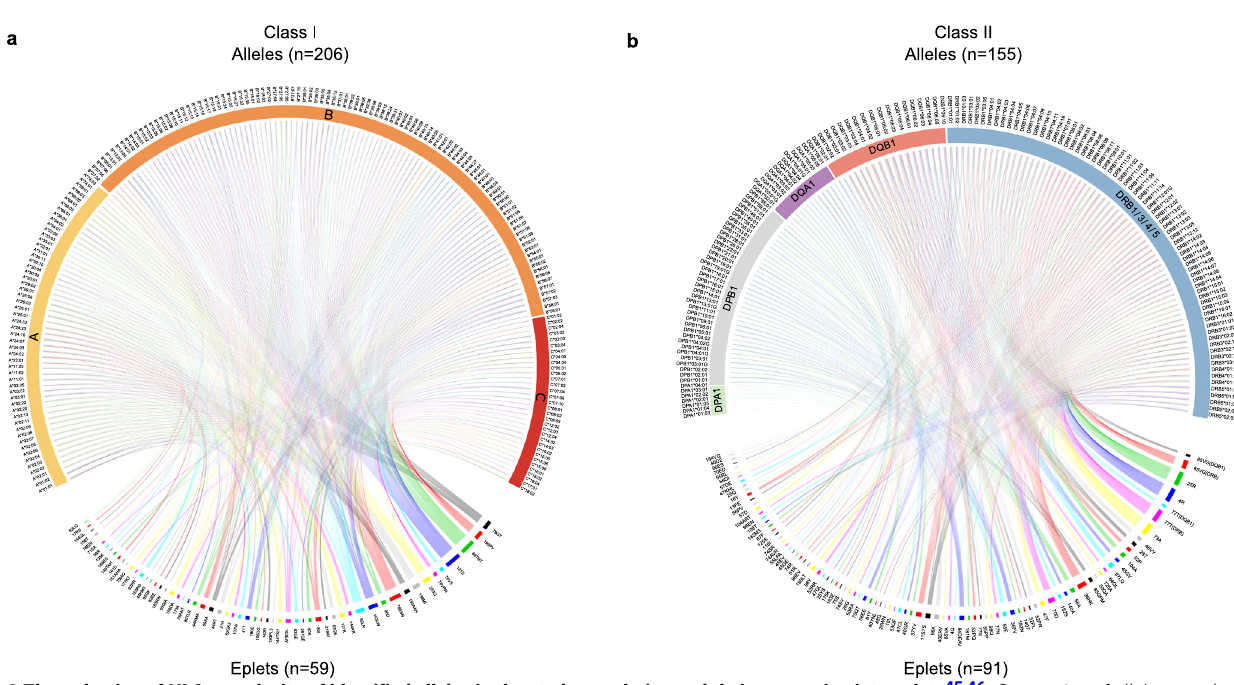
Fig. 3 The reduction of HLA complexity of identi fi ed alleles in the study population and their conversion into eplets 45,46 . Conversion of alleles to eplets was determined by HLAMatchmaker. HLA alleles identi fi ed in the study population are shown in top portion and eplets shown in the bottom portion. Interconnections represent an allele encoding an eplet or vice versa. a Class I alleles and eplets and b Class II alleles and eplets. COMMUNICATIONS BIOLOGY| (2021) 4:583